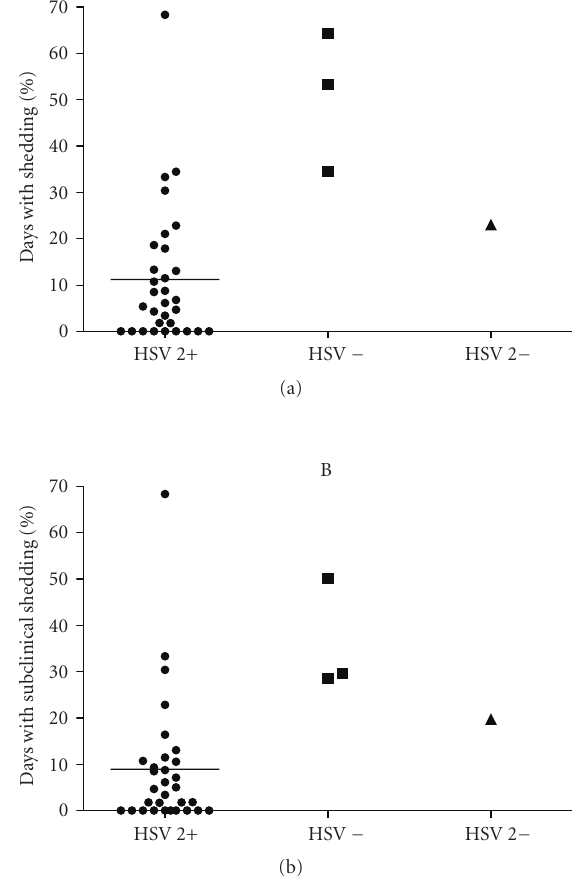
Figure 1: Scatter plot of shedding data for subjects receiving placebo in the first treatment period. The column labeled HSV-2 + shows data from subjects whose HSV-2 antibody test was positive at enrollment ( n = 31). The horizontal line represents the mean value. The next column shows the individual values for the 3 subjects who were negative for both HSV-1 and HSV-2 antibody; the next column shows the one subject who was HSV-1 antibody positive and HSV2 antibody negative at enrollment. (a) Total HSV-2 shedding, and (b) subclinical